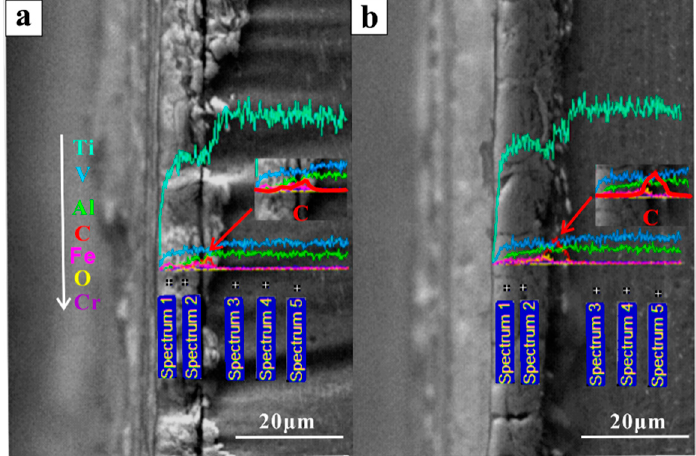
Figure 9. Energy dispersive spectroscopy (EDS) lines and points analysis of tribo-layer of the cross-sections of the ( a ) forged, ( b ) EBM samples.